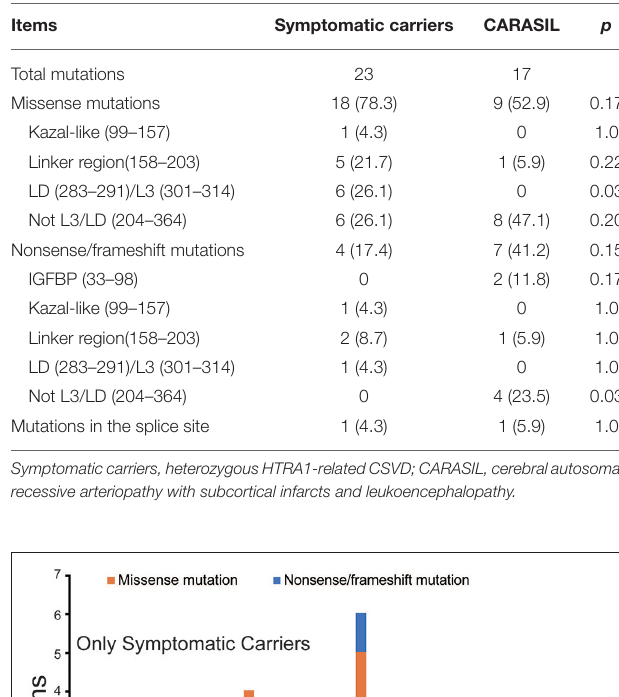
TABLE 2 | Summary of HTRA1 mutations identified in only one group.